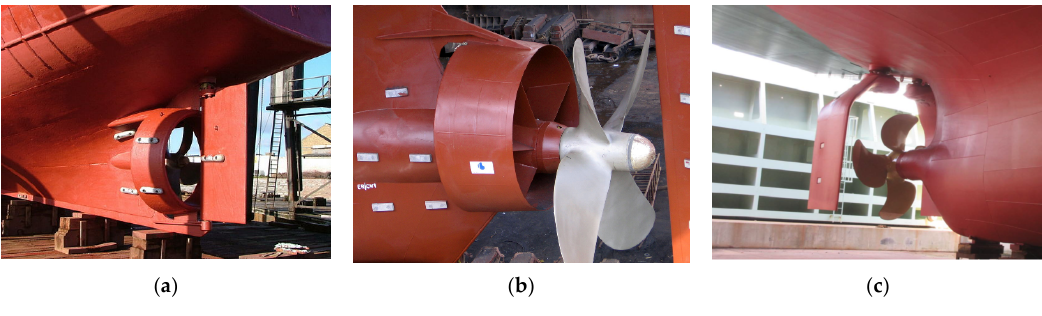
Figure 2. Kort nozzle ( a ), Becker Mewis Duct ( b ), and gate rudder system ( c ).